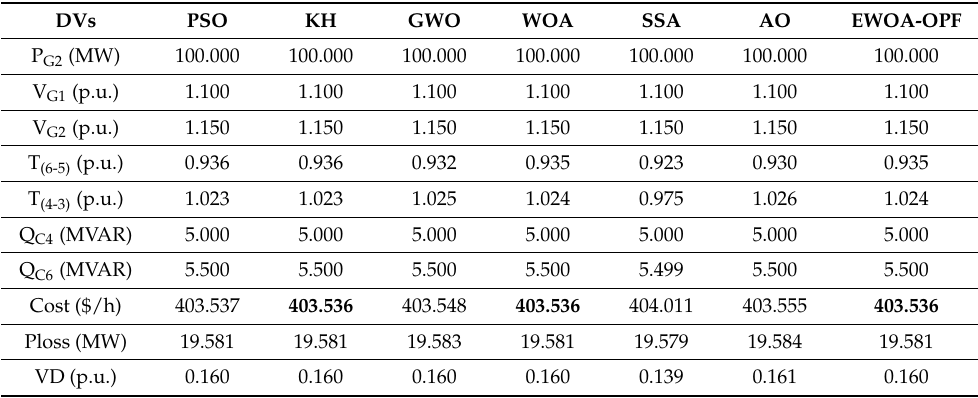
Table 2. Results of OPF for IEEE 6-bus test system on Case